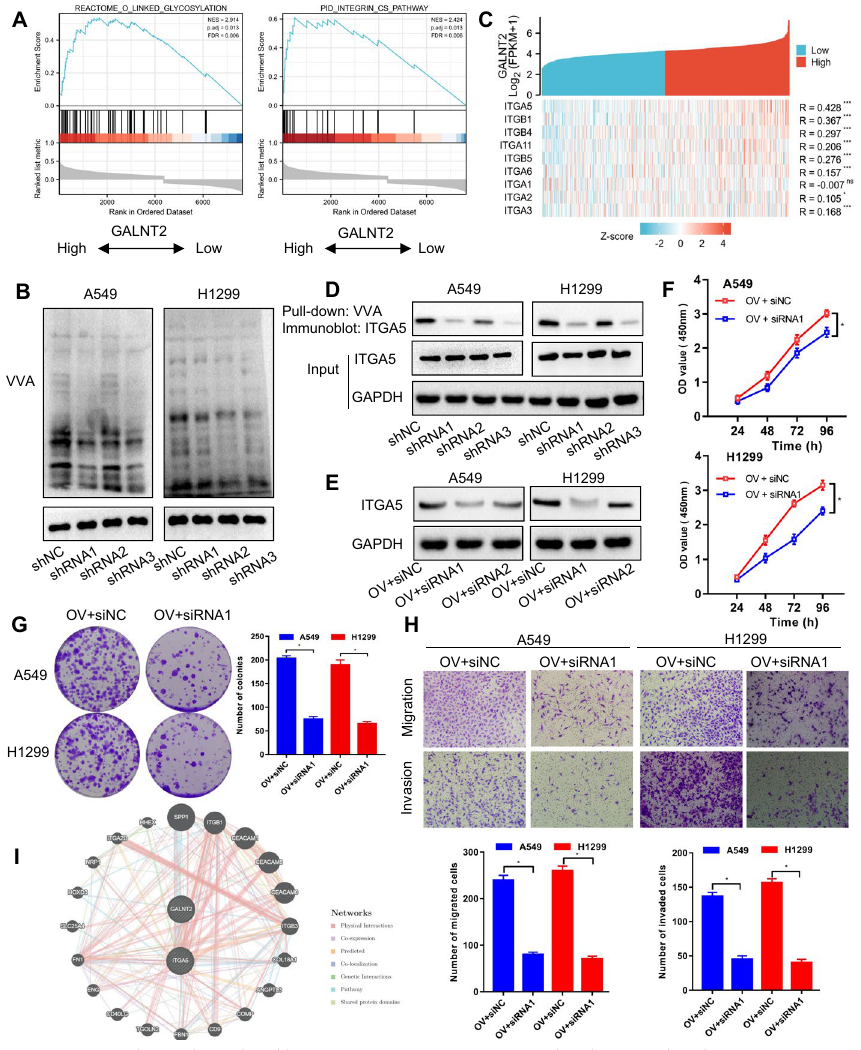
Fig. 7 ITGA5 can be O -glycosylated by GALNT2 in NSCLC. A Functional pathway analysis by GSEA. B VVA binding assay for the detection of O -linked glycosylation. C Heatmap displaying the Pearson correlation between GALNT2 and the Integrin pathway-related genes. D Detection of ITGA5 O -glycosylation by pull-down assay. E Western blot analysis of ITGA5 expression following siRNA transfection. F CCK-8 assay. G Colony formation assay. H Transwell migration and Matrigel invasion assays (magnification, protein interaction network. OV GALNT2 overexpression lentivirus, Mock normal control lentivirus, shRNA GALNT2 shRNA lentivirus, shNC negative control shRNA lentivirus, siRNA ITGA5 siRNA, siNC negative control siRNA, NS no significance; * P < 0.05; ** P < 0.01; *** P <